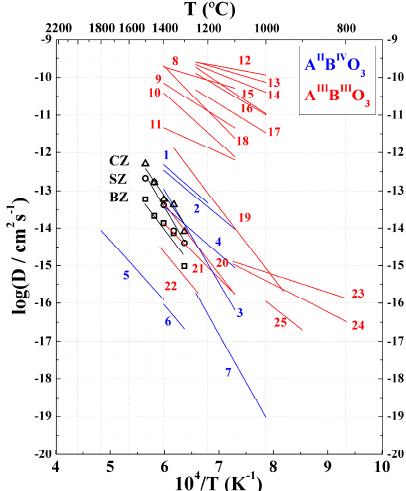
Figure 6. Zr diffusivity in AZrO 3 compared for A II B Iv O 3 and A III B III O 3 perovskites. Abbreviations: p—